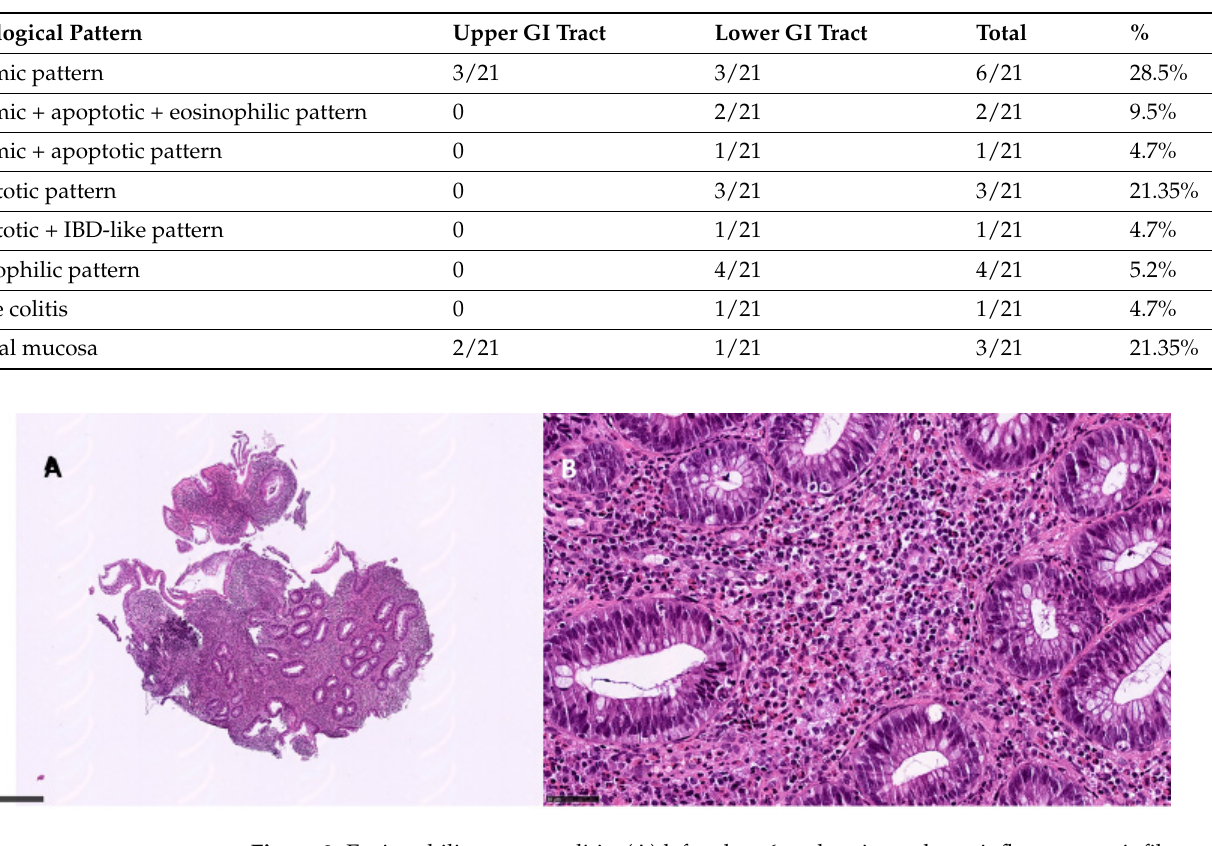
Figure 3. Eosinophilic pattern colitis: ( A ) left colon, 6×, showing a dense inflammatory infiltrate in the lamina propria with middle glandular distortion; ( B ) eosinophils > 60/HPF in the lamina propria (hematoxylin and